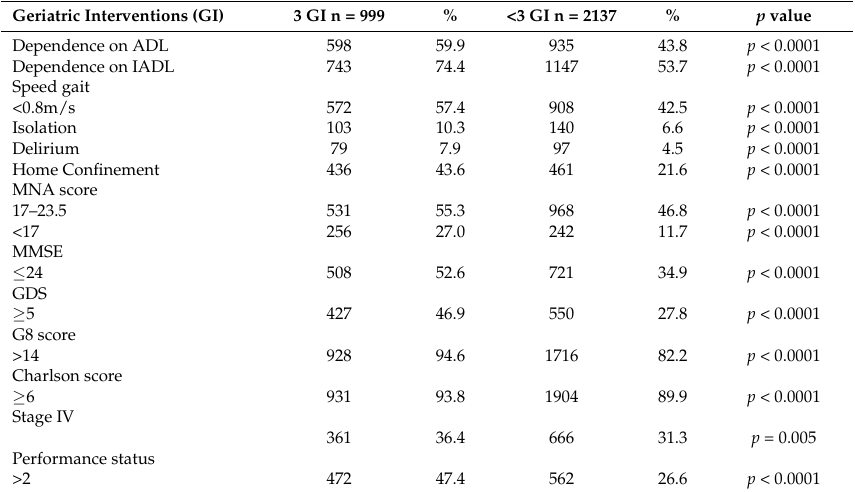
Table 4. Univariate significant factors of an increased need of geriatric